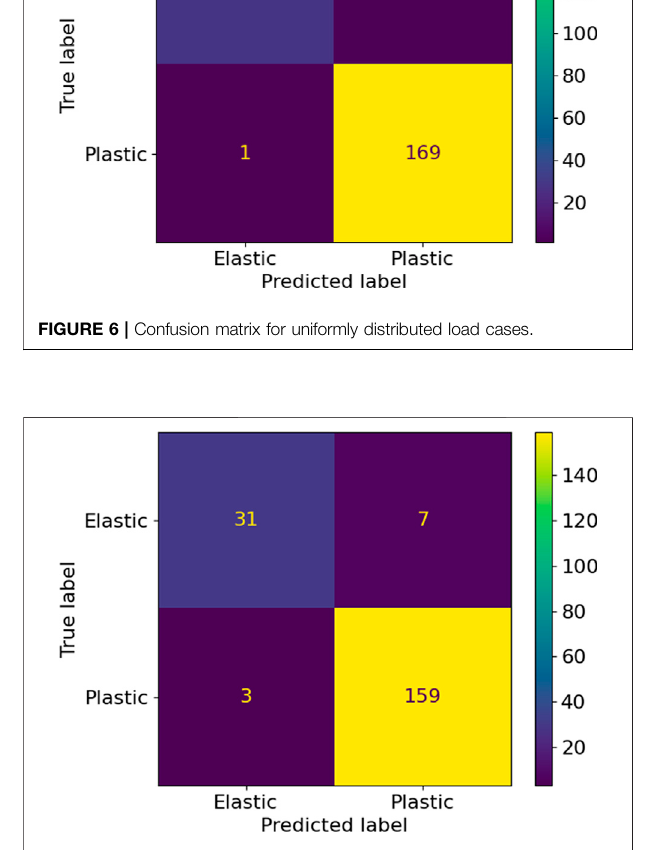
FIGURE 7 | Confusion matrix for randomly distributed load